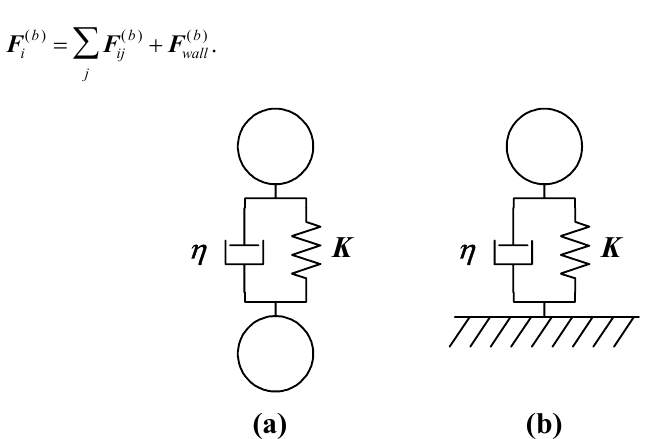
Fig. 1 Voigt model used for the binding force and the contact force. The Voigt model consists of parallel spring, which has elastic modulus η , and dashpot, which has viscosity coefficient K . The identical model was applied for both (a) the particle-particle and (b) the particle-surface